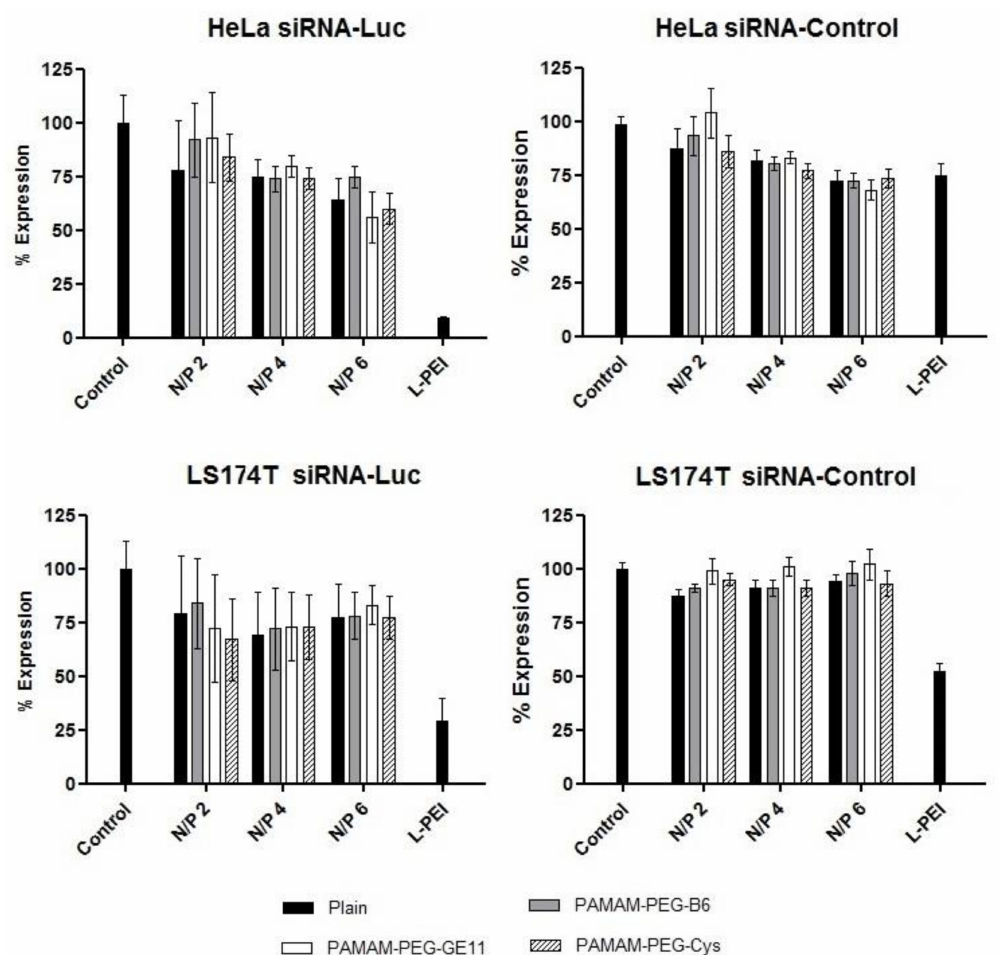
Figure 3. Luciferase silencing efficacy of PAMAM-G5 (Plain) and PAMAM-PEG-GE11/B6/Cys dendriplexes with specific siRNA-Luc or siRNA-control complexes prepared at various N/P ratios. Provided data represent the percentage of expression compared to non-treated (control) cells. Data are expressed as the mean ± SD ( n = 8). Differences were considered statistically different at p <